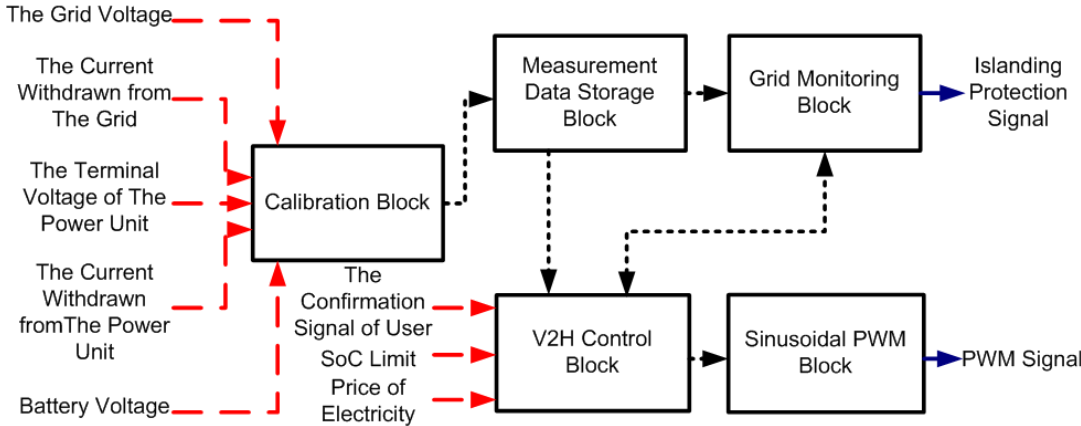
Figure 8. The control algorithm of the test platform.